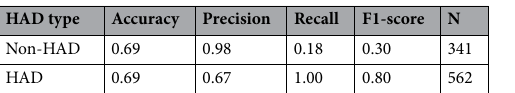
Table 10. Prediction performance of HAD binary classification in IPD data